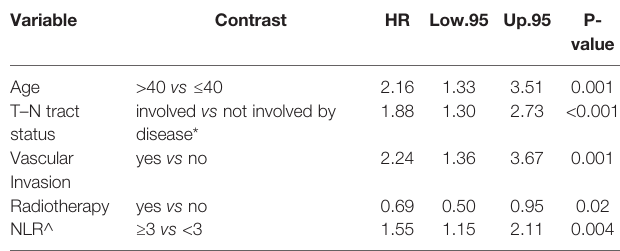
TABLE 4 | Multivariate Cox model for CSS.